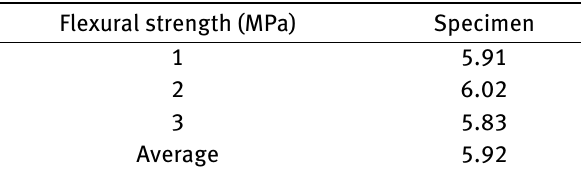
Table 19: Flexural strength of traditional